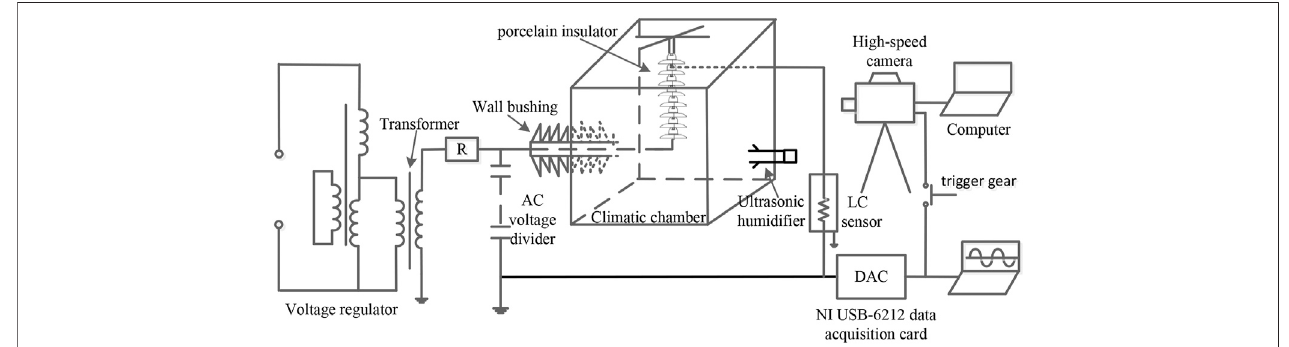
FIGURE 1 | Schematic diagram of the arti fi cial pollution test.